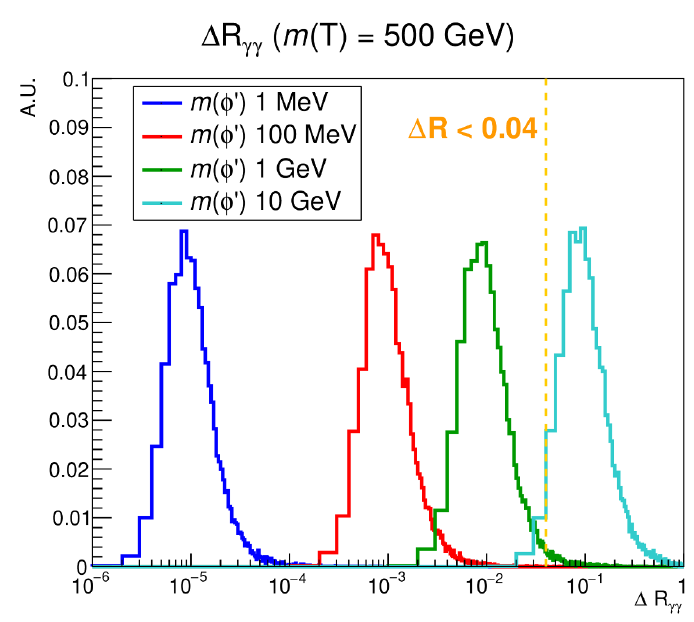
Figure 3 . The distribution of ∆ R γγ for m ( φ 0 ) = 1 MeV (blue), 100 MeV (red), 1 GeV (green) and 10 GeV (cyan), assuming m ( T ) = 500 GeV . The normalization of the y -axis is arbitrary. The vertical dashed orange line denotes ∆ R γγ = 0 . 04 ; for events to the left of this line, the two photons cannot be